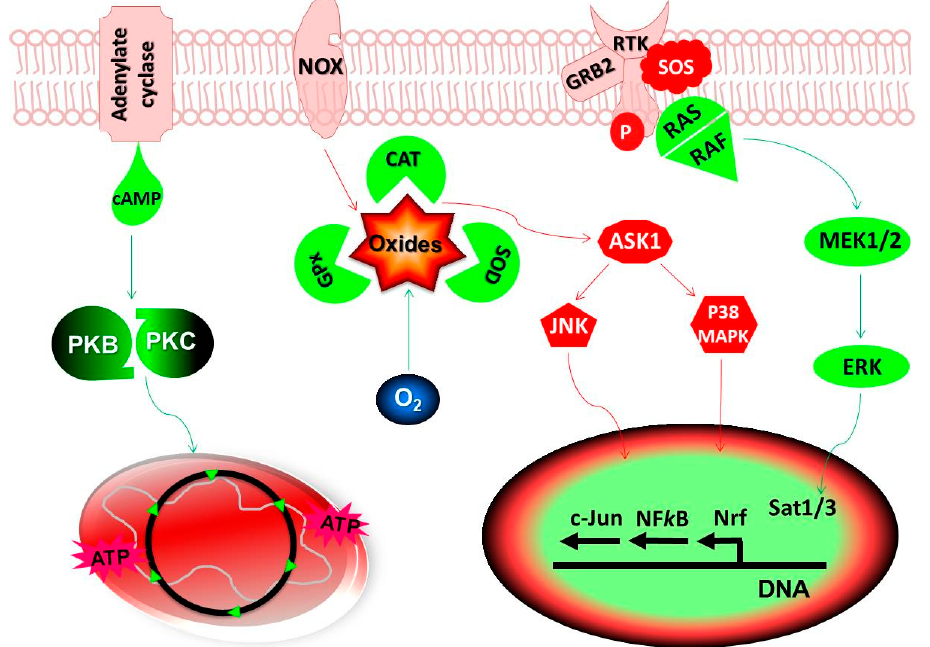
Figure 1. Redox potential of antioxidants: In healthy cells, oxide free radicals generated from mitochondria and cell membrane NADPH Oxidases (NOX) are detoxified by the endogenous antioxidants, catalases (CAT), Glutathione Peroxidases (GPx) and Superoxide Dismutases (SOD). A constitutively low level of Reactive Oxygen Species (ROS) stimulate Protein Kinases (PK) B / C for maintaining cellular homeostasis while, higher levels can result in the change in mitochondrial membrane potential leading to apoptosis or cell death. Cancer cells have higher levels of oxidative stress as compared to the normal cells allowing them to activate several signaling pathways and transcription factors. Any imbalances in the redox-sensitive signaling pathways, Mitogen Activated Protein Kinases (MAPK) and PK B / C may result in the tumor growth. The Ras-Raf-MEK-ERK pathway (also known as the MAPK / ERK pathway) is the signaling cascade from cell membrane receptor complex to the nucleus. During excessive oxidative stress, Apoptosis Signal-regulating Kinase 1 (Ask1) induces apoptosis by activating c-Jun N-terminal Kinases (JNK) and p38 MAPK pathways. It may also lead to the inactivation and proteolytic degradation of PK molecules leading to the initiation of apoptosis or cell death signaling. The redox regulation of cellular oxidative stress is achieved either by activation or repression of the antioxidant genes through several transcription factors, acting individually or in combination. Objects in RED show the pathways activated directly by oxides radicals and the objects in GREEN indicate pathways regulating the cellular antioxidant mechanisms. Abbreviations: cAMP, cyclic Adenosine Monophosphate; ATP, Adenosine Triphosphate; ERK, Extracellular Signal-regulated Kinases; O 2 , oxygen.